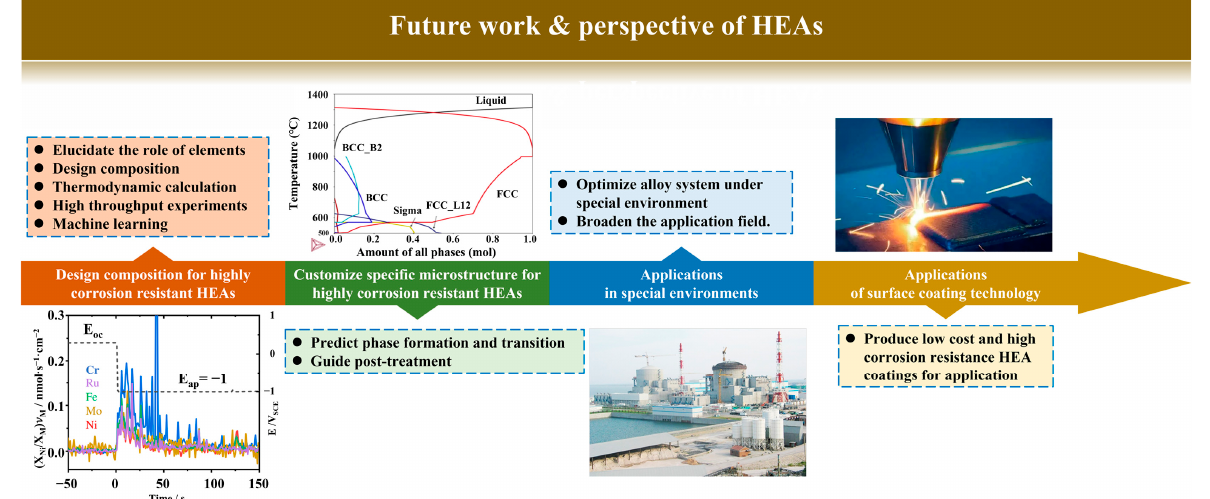
Figure 16. Proposed future work and perspectives for the corrosion fields of HEAs, including design composition for highly corrosion resistant HEAs, customized specific microstructures for highly corrosion resistant HEAs, applications in special environments, and applications of surface coating technology. The red part represents the composition design for highly corrosion resistant HEAs, the different colours of the lines represent different elements; the green part represents the customize specific microstructure for highly corrosion resistant HEAs, the blue part represents the application of HEAs in special environment, and the brown represents the application of HEAs of surface coat- ing technology [26,63].